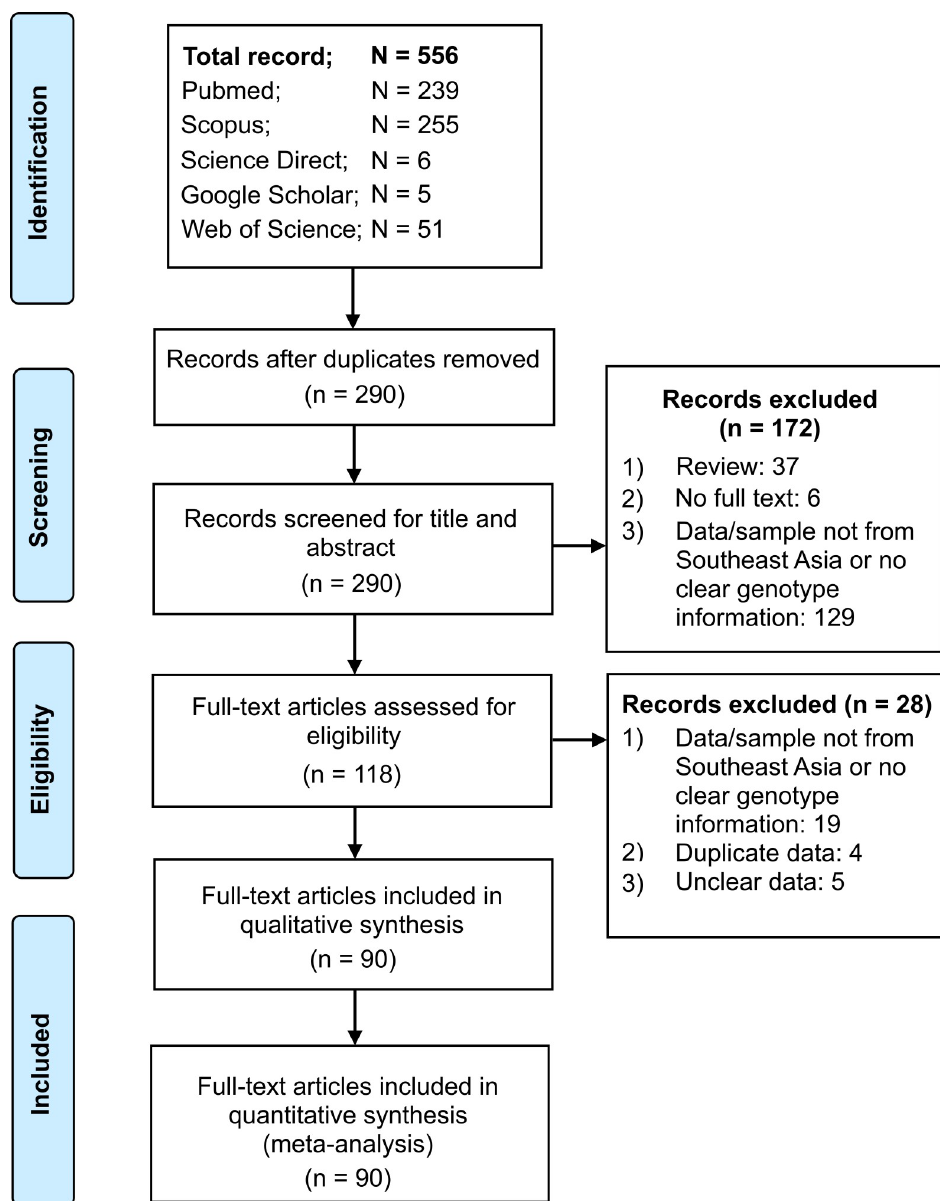
Fig 1. Summary of article identification and selection